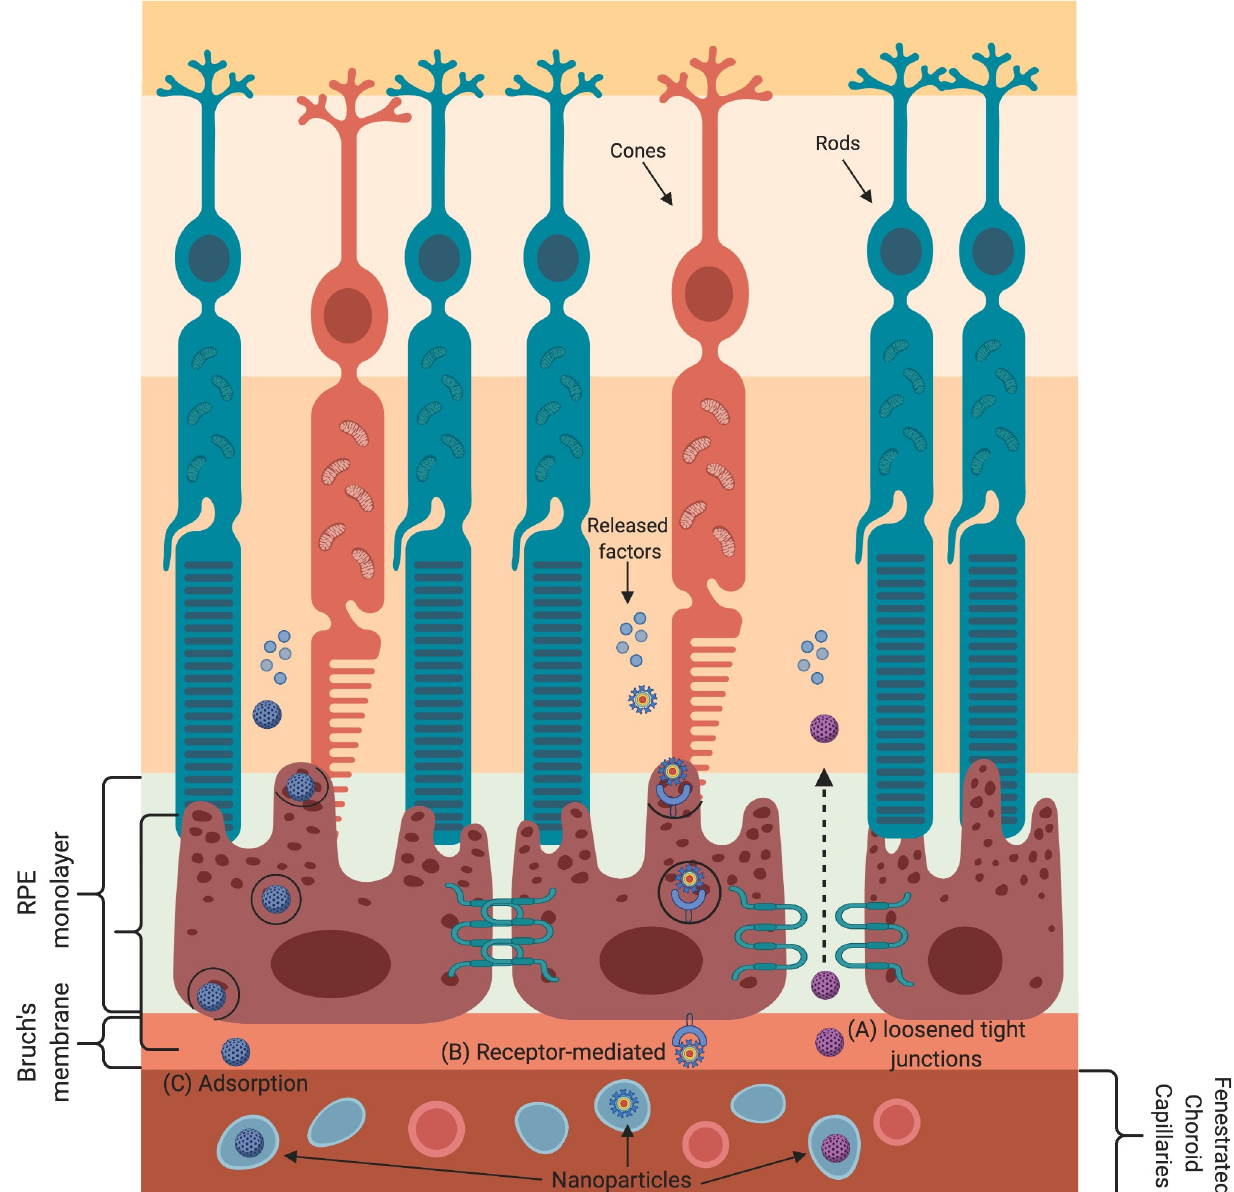
Figure 3. Transport mechanisms for delivering nanoparticles (NPs) into the blood–retinal barrier (BRB). The BRB is exceedingly selective and has unambiguous transport mechanisms allowing a close control of molecules/cells that enter the retina. Loosening of tight junctions (TJs) either due to the presence of a surfactant in NPs or by BRB impairment due to pathological conditions allows the movement of NPs through the BRB. ( A ) NPs’ admittance into the retina is through receptor-mediated transcytosis. ( B ) The NPs interact with respective receptors on the endothelial cell surface, which leads to plasma membrane invaginations, vesicle formation, and, therefore, the release of the NPs at the other side of the membrane. ( C ) NPs coated with chitosan or other polysaccharides can cross the BRB by adsorptive transcytosis.